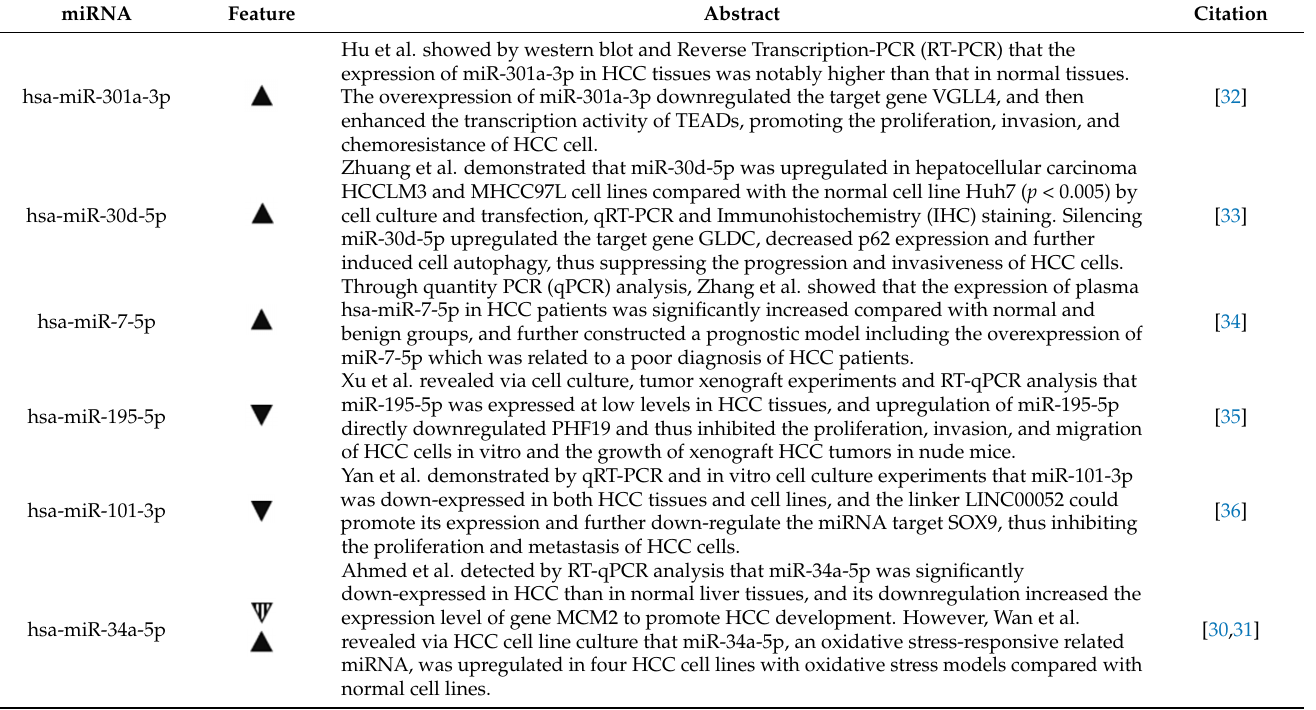
Table 3. A comparison between the abnormal expressions of six prognostic miRNAs reported in this study and previous